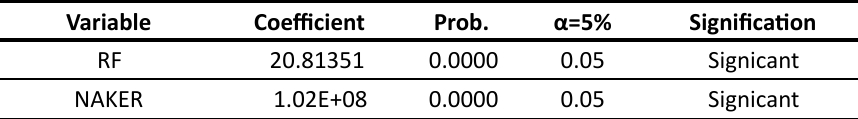
Table 2 : T Statistics Test